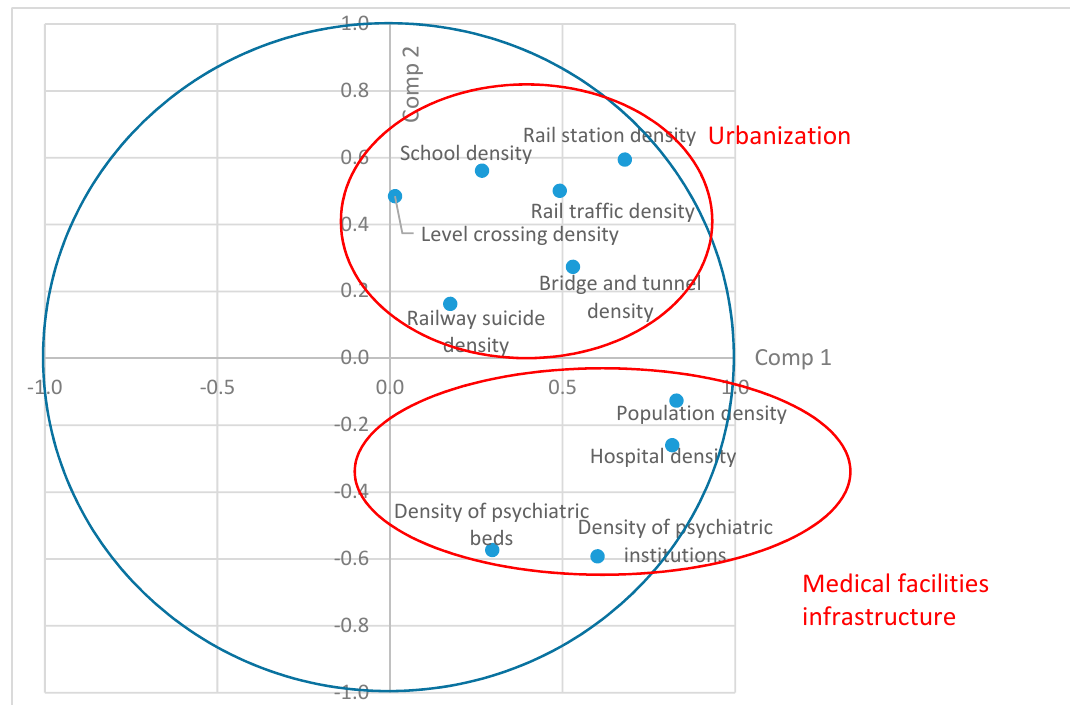
Figure 1. Saturation levels on Component One and Component Two.